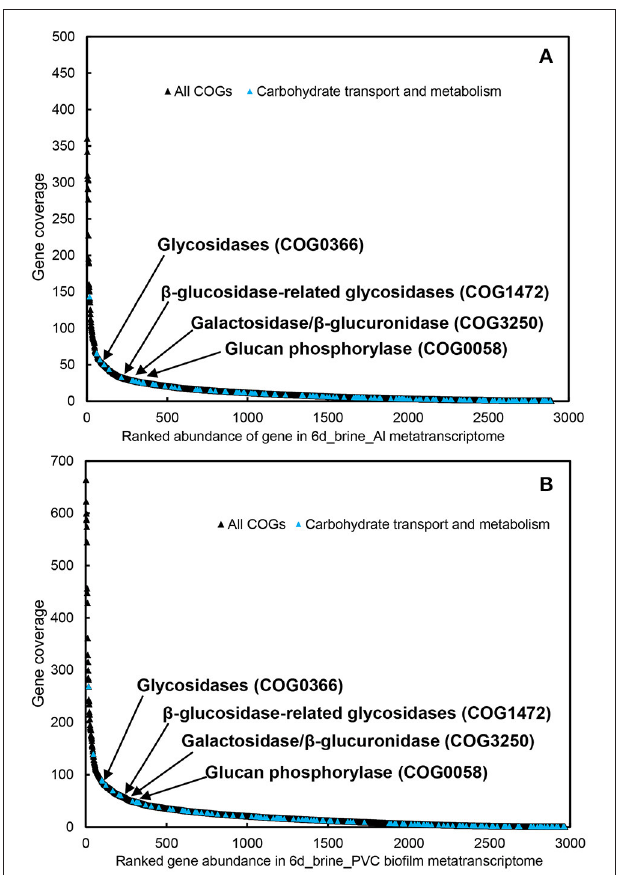
FIGURE 3 | Transcript abundance of all COGs and carbohydrate transport and metabolism genes in the two biofilm metatranscriptomes ( A , biofilm_Al; B , biofilm_PVC). Genes for Glycosidases (COG0366), β -glucosidase-related glycosidases